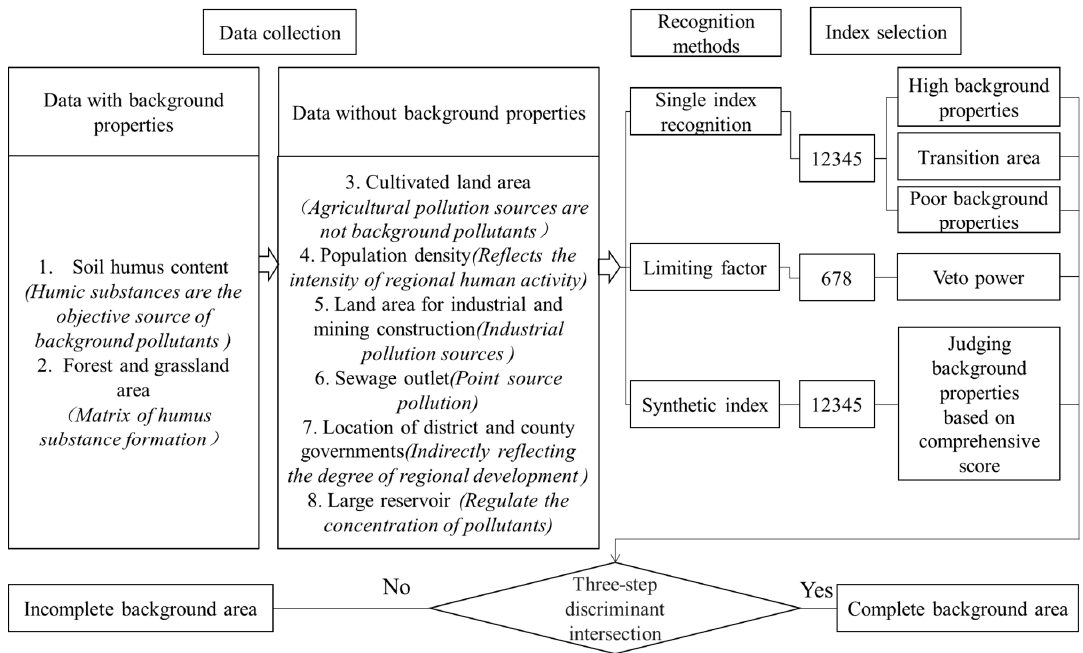
Figure 5. Process of discriminating background areas.